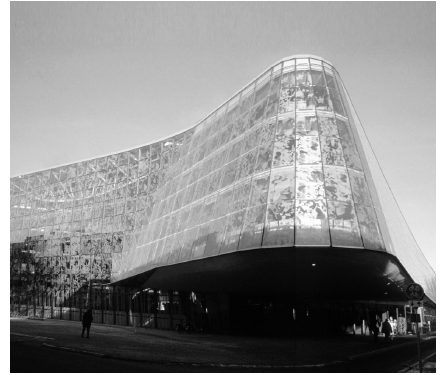
Figure 1: Overall view of the town hall